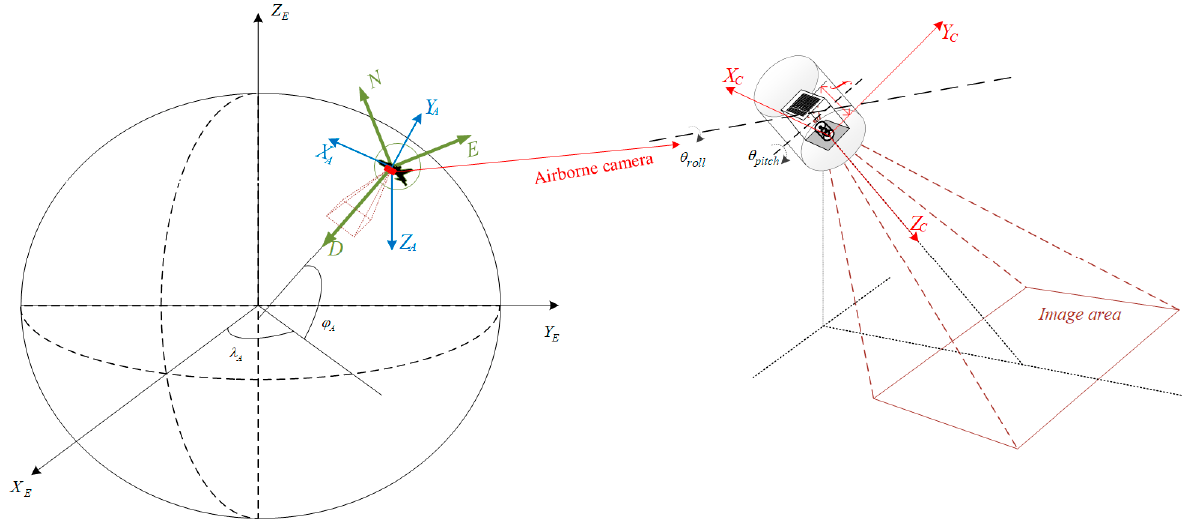
Figure 3. Coordinate system in airborne image geographic positioning.